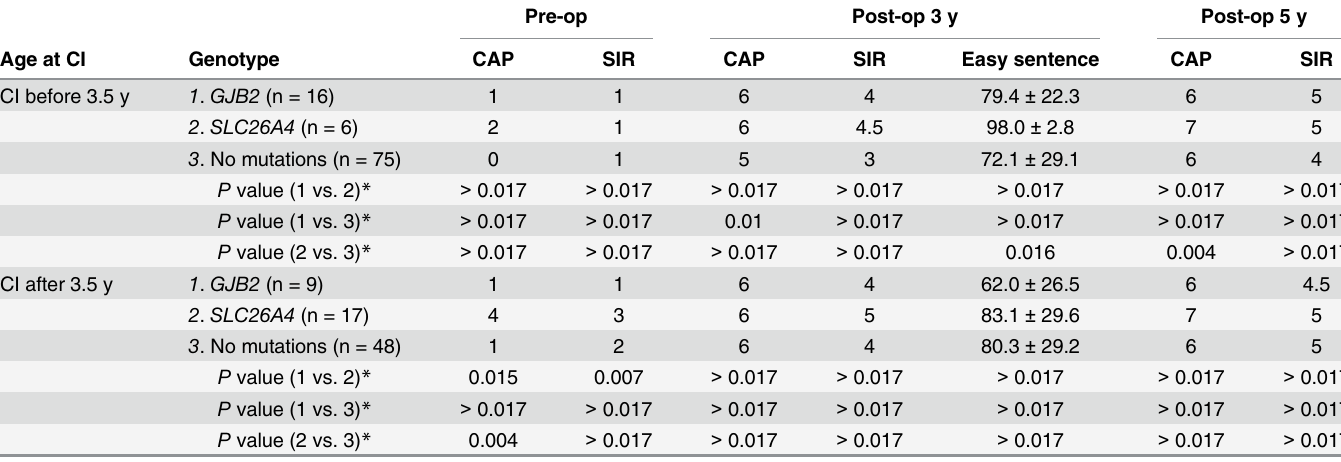
Table 7. CAP and SIR scores in subjects broken down by age at implantation (before and after 3.5 years) and genotypes ( GJB2 , SLC26A4 and no mutations). Pre-op Post-op 3 y Post-op 5